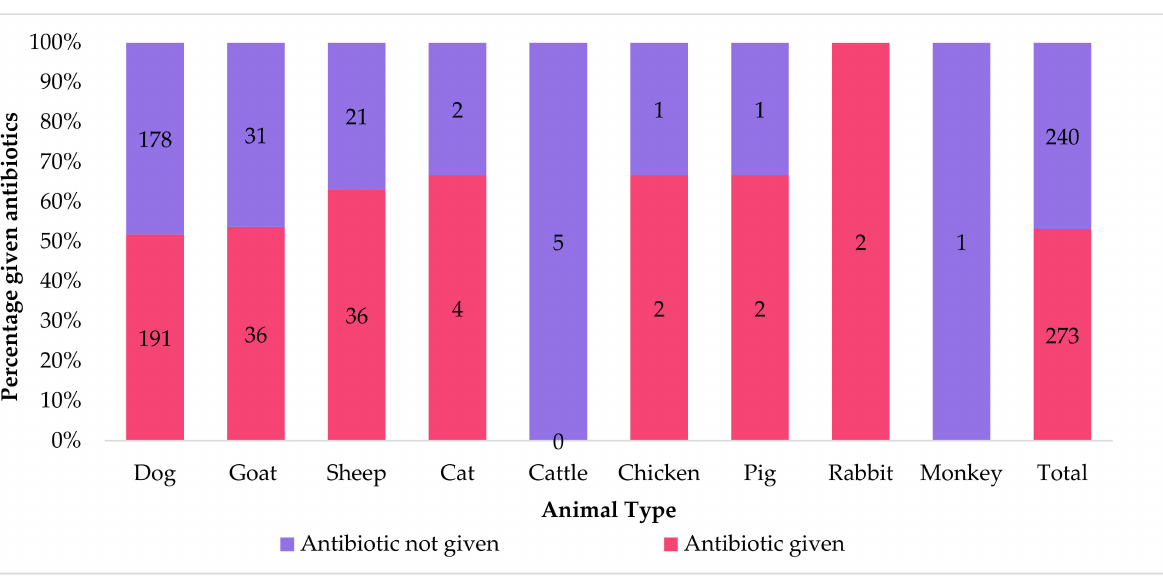
Figure 3. Number and proportion of antibiotic use by type of animal that received antibiotics from the Kintampo Municipal Veterinary Clinic in Ghana,